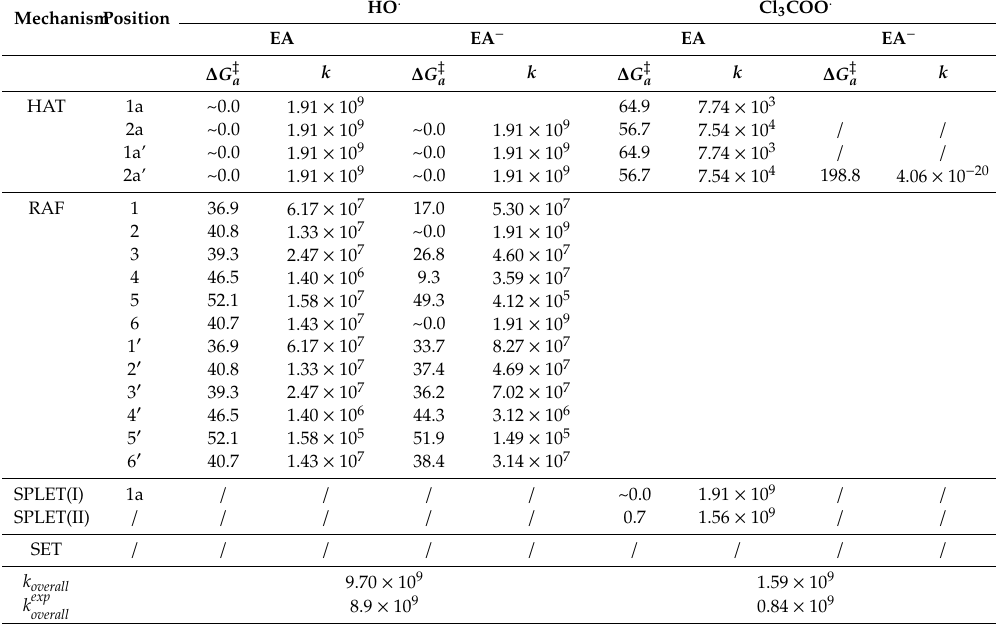
Table 2. Activation energies ∆ G pathways of the reactions of EA and EA − with HO • and CCl 3 OO • .